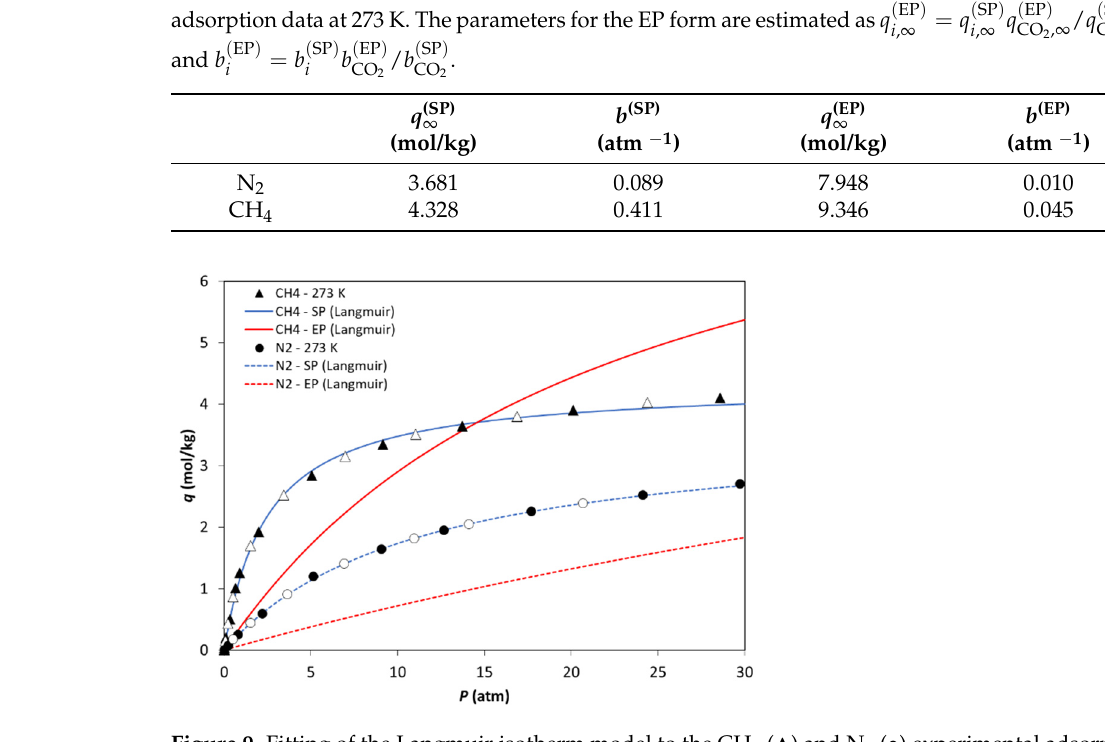
,(cid:2998)(EP) /𝑞 ,(cid:2998)(SP) CO (cid:3118) CO (cid:3118)